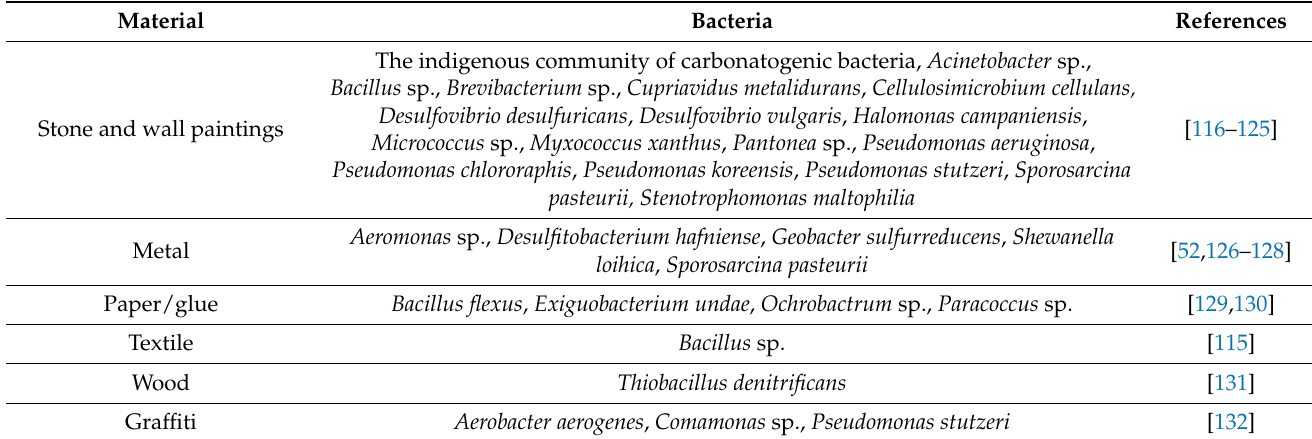
Table 2. Examples of bacteria applied in biotreatment of cultural heritage